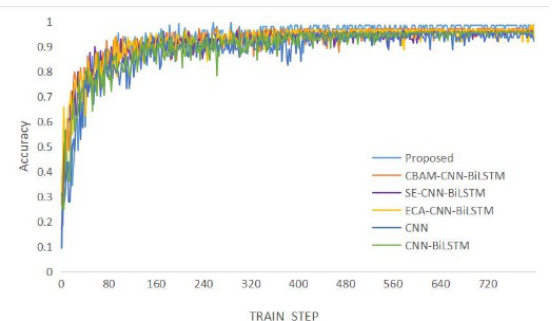
Figure 9. Training accuracy of different models.